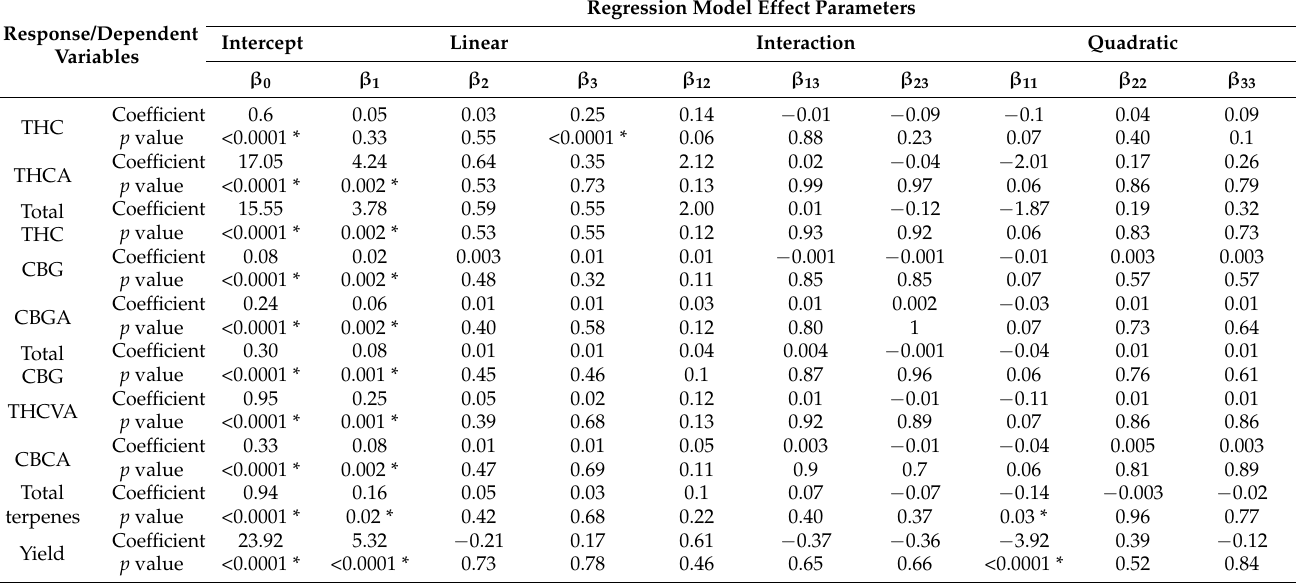
Table 5. Matrix of the central composite rotatable statistical design (CCRD) and observed responses (Y j ) for microwave-assisted extraction using model E (Y j = β 0 + β 1 X 1 + β 2 X 2 + β 4 X 4 + β 11 X 1 X 1